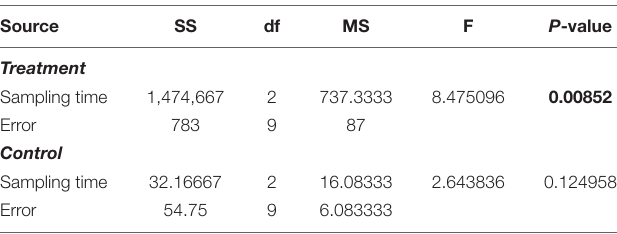
TABLE 5 | Results from permutation analysis of variance (PERMANOVA) analysis of hard substrates under the cages. Source df MS Pseudo-F P(perm)